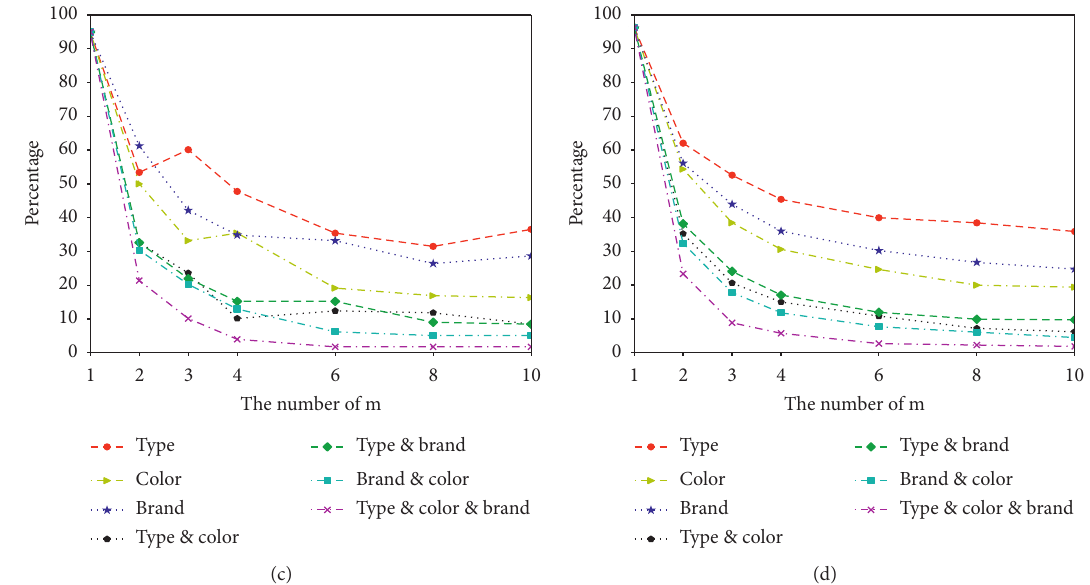
Figure 7: The change curve of p with different ms and ns . (a) The results of Case 1. (b) The results of Case 2 (VLPR 1 and VLPR 2). (c) The results of Case 2 (VLPR 1 and VLPR 3). (d) The results of Case 2 (VLPR 1 and VLPR